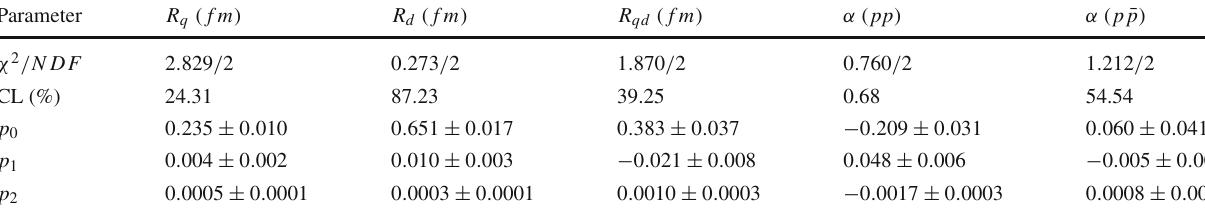
Table 3 Summary of the parameter values which determine the energy dependenceaccordingtothequadraticdependenceinln ( s ) byEq.(D.1). The values of the parameters are rounded up to three valuable decimal digits except for p 2 that are rounded up to four valuable decimal digits.